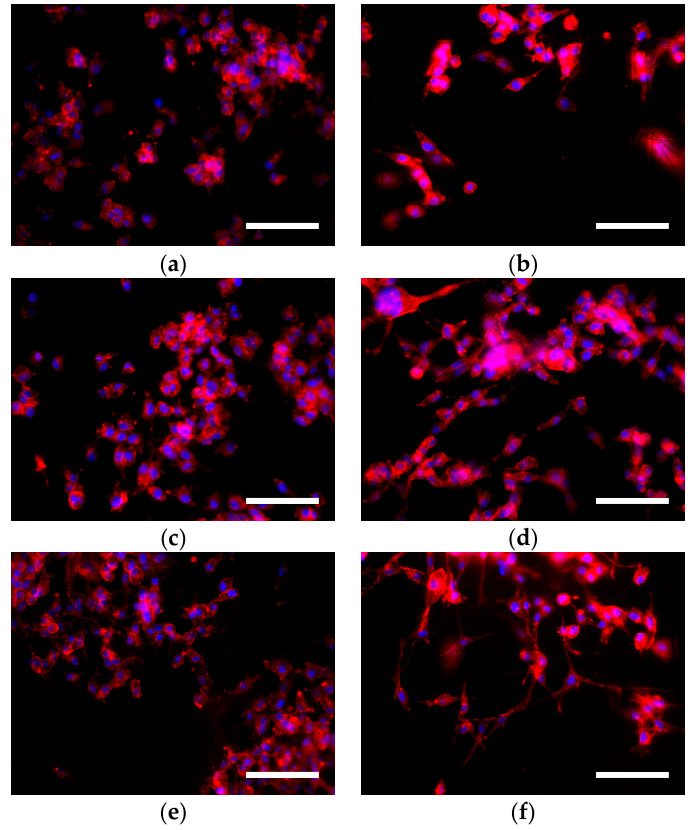
Figure 3. MDA–MB–231 cells grown in three-dimensional (3D) PCL scaffolds. Cells were seeded on 7.5% PCL ( a , c , e ) and 15% PCL meshes ( b , d , f ). Cells were cultured for 3 ( a , b ), 6 ( c , d ) and 12 days ( e , f ) without passage. Actin cytoskeleton was stained with rhodamine-phalloidin (red) and nucleus was stained with DAPI (blue). Fluorescence microscopy images were captured at a magnification of 200× (Scale bars: 100 μ m).